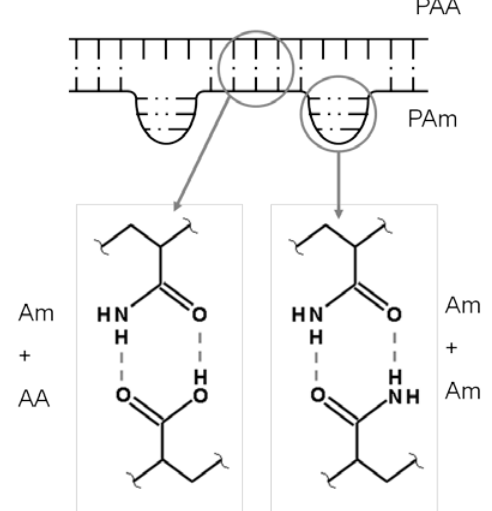
Figure 4. Competing hydrogen bond complexations in PAm and PAA hydrogels. Adapted from